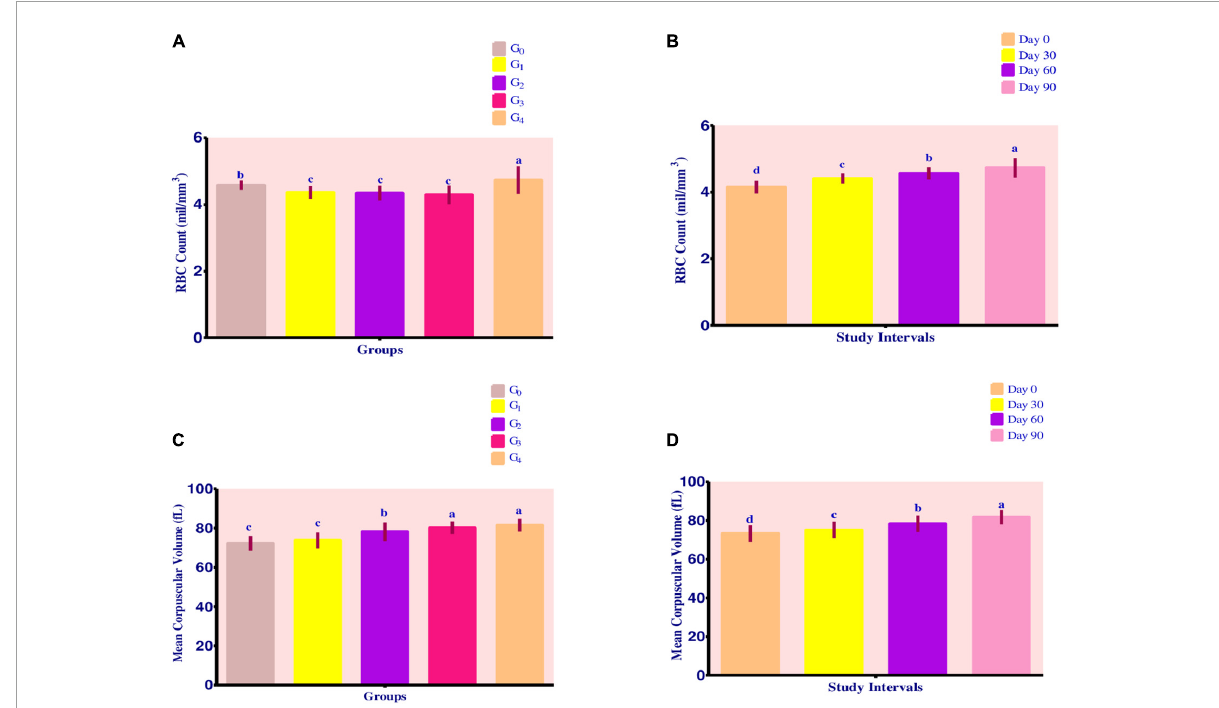
FIGURE2 (A–D) Effect of fortified diets on RBC count and MCV among anemic women data are presented as Means ± SD . P -value < 0.05 is considered to be significant. Means carrying the same letters are not significantly different.